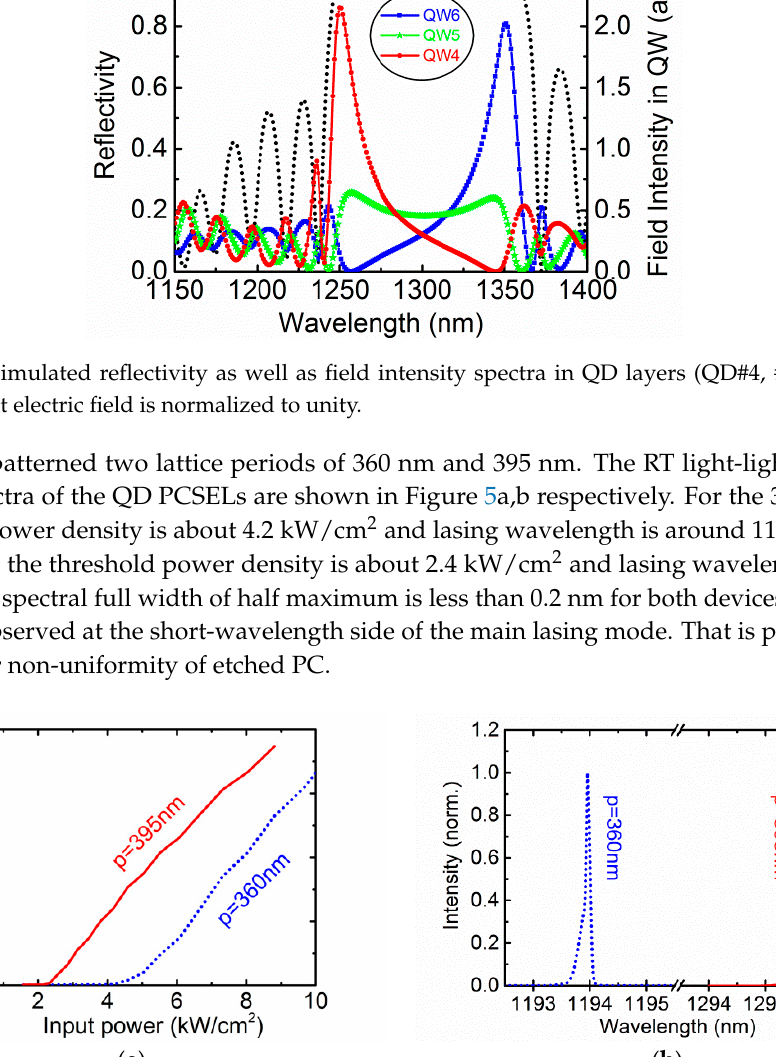
Figure 5. ( a ) Light-light ( L-L ) curves and ( b ) lasing spectra of QD PCSELs with periods of 360 nm and 395 nm.